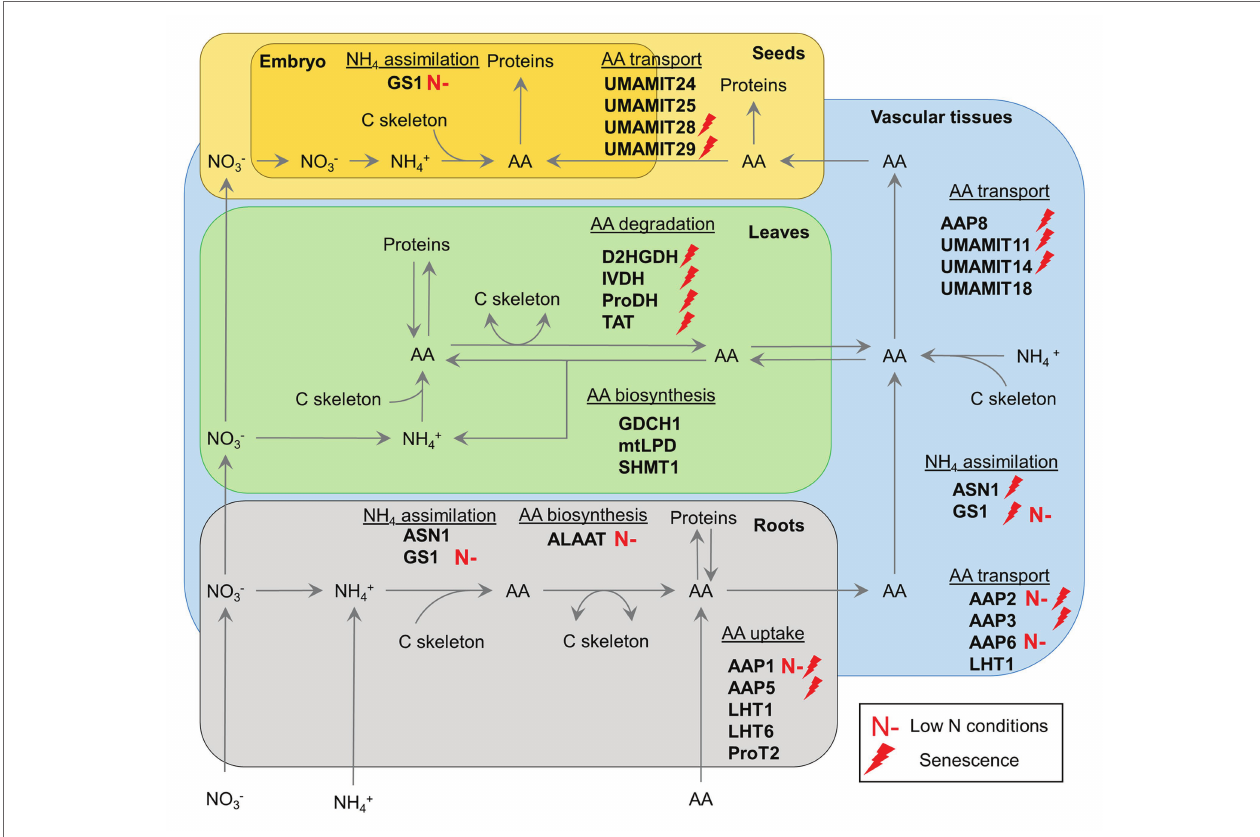
FIGURE 1 | Current and promising targets for genetic manipulation of amino acid metabolism and transport to improve crop nitrogen use efficiency for a sustainable agriculture. Red lightning refers to gene targets known to be upregulated during senescence. Red “N-” refers to targets with a known biotechnological potential in low N conditions in certain crops. AAP, amino acid permease; ALAAT, alanine:2-oxoglutarate aminotransferase; ASN, asparagine synthetase; D2HGDH, D-2-hydroxyglutarate dehydrogenase; GDCH, H-protein of the glycine decarboxylase complex; GS, glutamine synthetase; IVDH, isovaleryl-CoA dehydrogenase; LHT, lysine histidine transporter; mtLPD, mitochondrial L-protein of the glycine decarboxylase complex; ProDH, proline dehydrogenase; ProT, proline transporter; SHMT, serine hydroxymethyl aminotransferase; TAT, tyrosine aminotransferase; UMAMIT, usually multiple amino acid move in and out